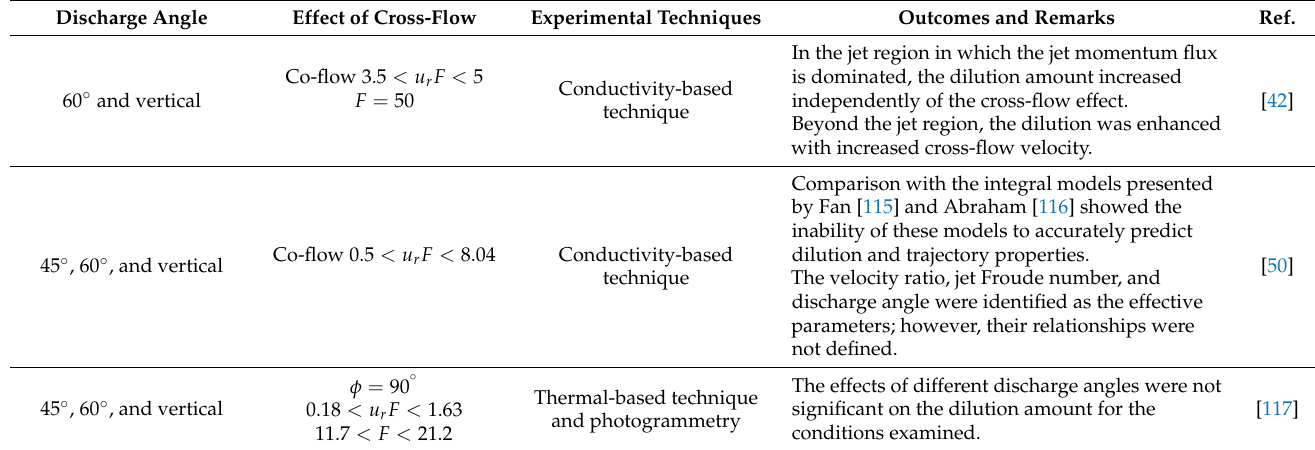
Figure 17. Effect of ambient current speeds on general flow characteristics of one-sided multiport diffusers with narrow and wide port spacings [51]. Table 4. Highlighted research efforts on the mixing behavior of single dense jets impacted by flowing